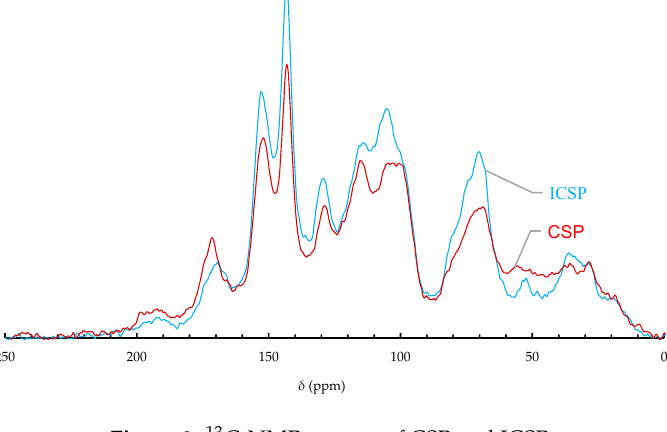
Figure 3. 13 C-NMR spectra of CSP and ICSP. Table 1. Relative abundances of different carbon in CSP and ICSP estimated from 13 C-NMR data.